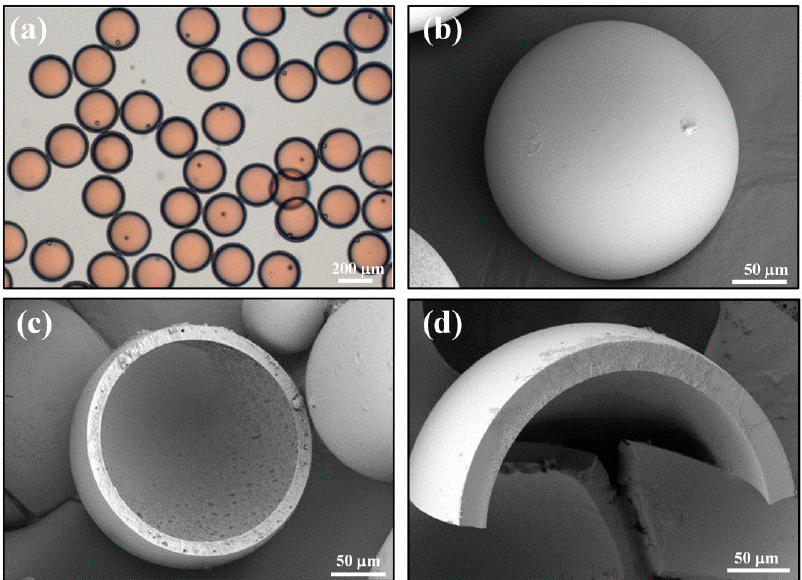
Figure 4. ( a ) Optical microscopy of monodisperse core–shell microcapsules after curing. SEM images of ( b ) an integral microcapsule, ( c ) a ruptured microcapsule, and ( d ) close-up view of a microcapsule’s shell.